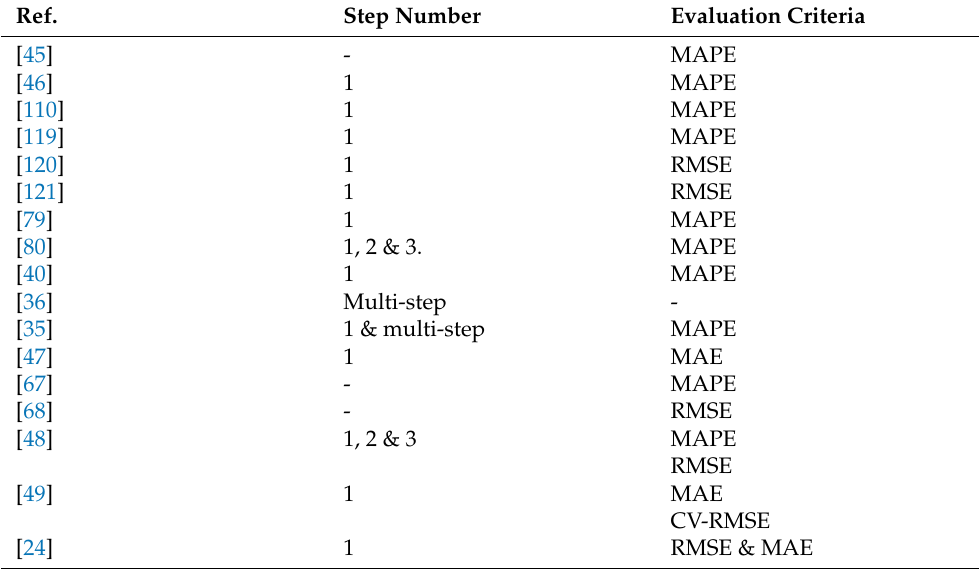
Table 4. Studies carried out with an ultra-short-term prediction horizon. Ref. Step Number